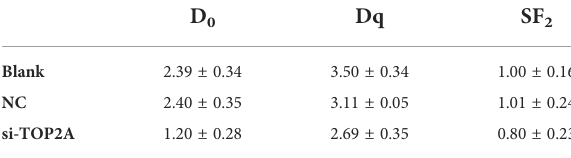
TABLE 5 Parameters of radiosensitivity in different groups of Daoy